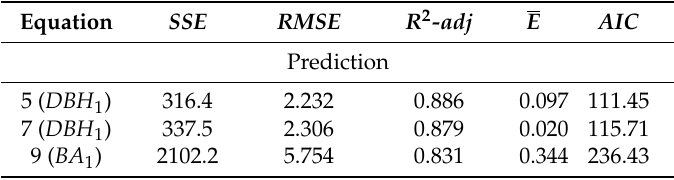
Table 3. Goodness-of-fit statistics of prediction and projection